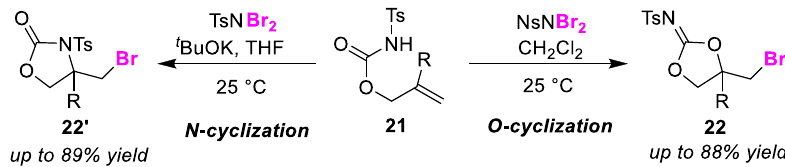
Figure 12. O / N atom-selective bromocyclizations of olefinic N -tosylcarbamates 21 Figure 12. O/N atom-selective bromocyclizations of olefinic N -tosylcarbamates 21 .